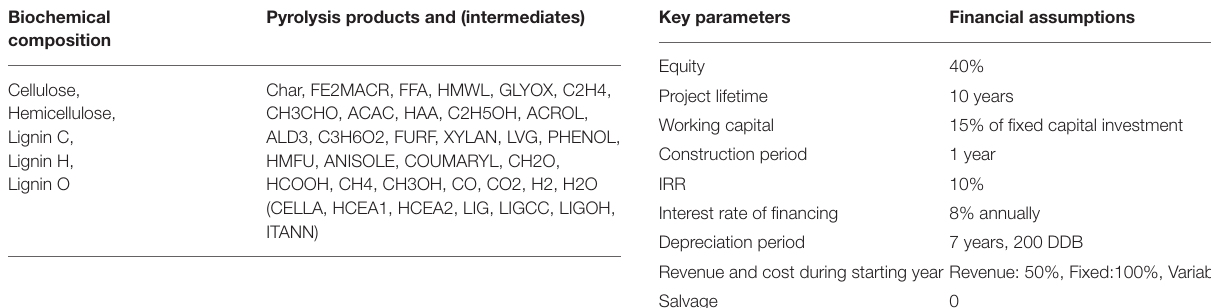
Biochemical composition